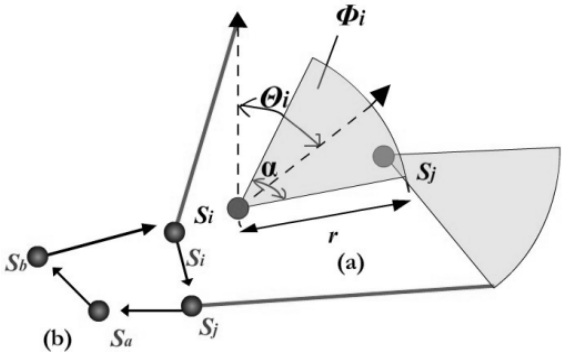
(cid:198) S (cid:198) S (cid:198) S j a b j